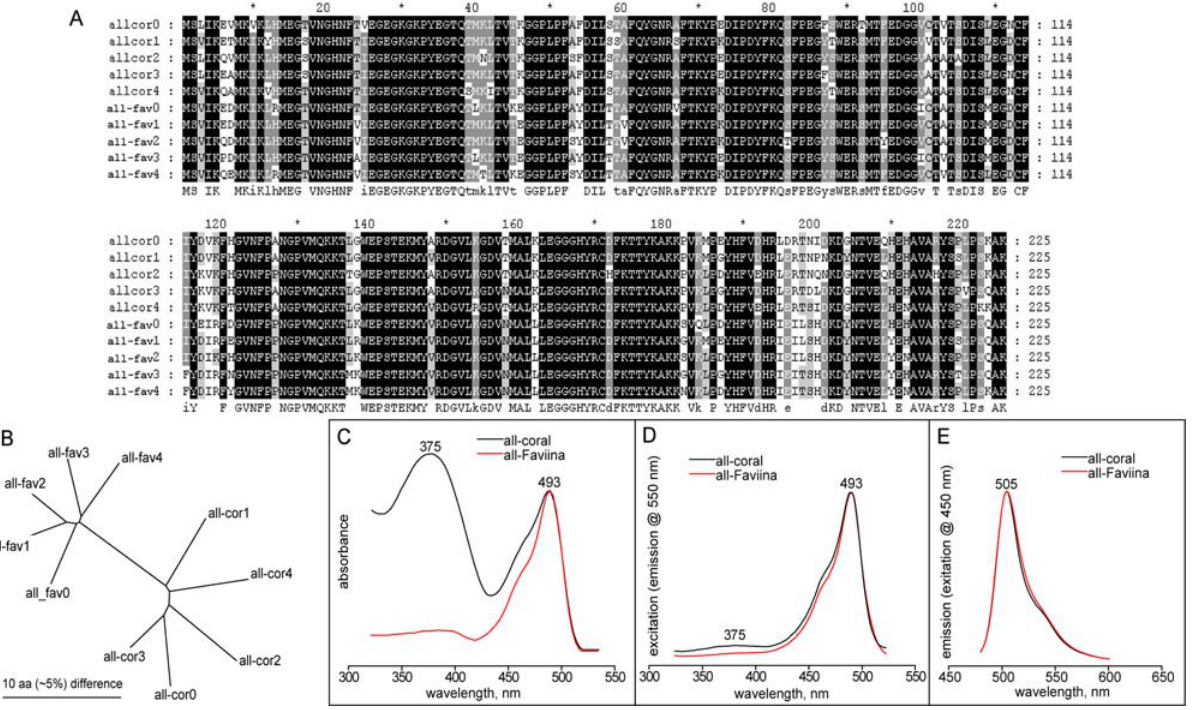
Figure 3. Analysis of ancestral proteins. A: alignment of the amino acid sequences of the reconstructed ancestral variants, five corresponding to All-coral ancestor (all-cor, 0 to 4) and five corresponding to All-Faviina ancestor (all-fav, 0 to 4). B: Unrooted neighbor-joining tree illustrating the degree of divergence between the synthesized ancestral sequences. C–E: absorbance, excitation, and emission spectra of a representative all-coral ancestor (black curves) and all-Faviina ancestor (red curves).